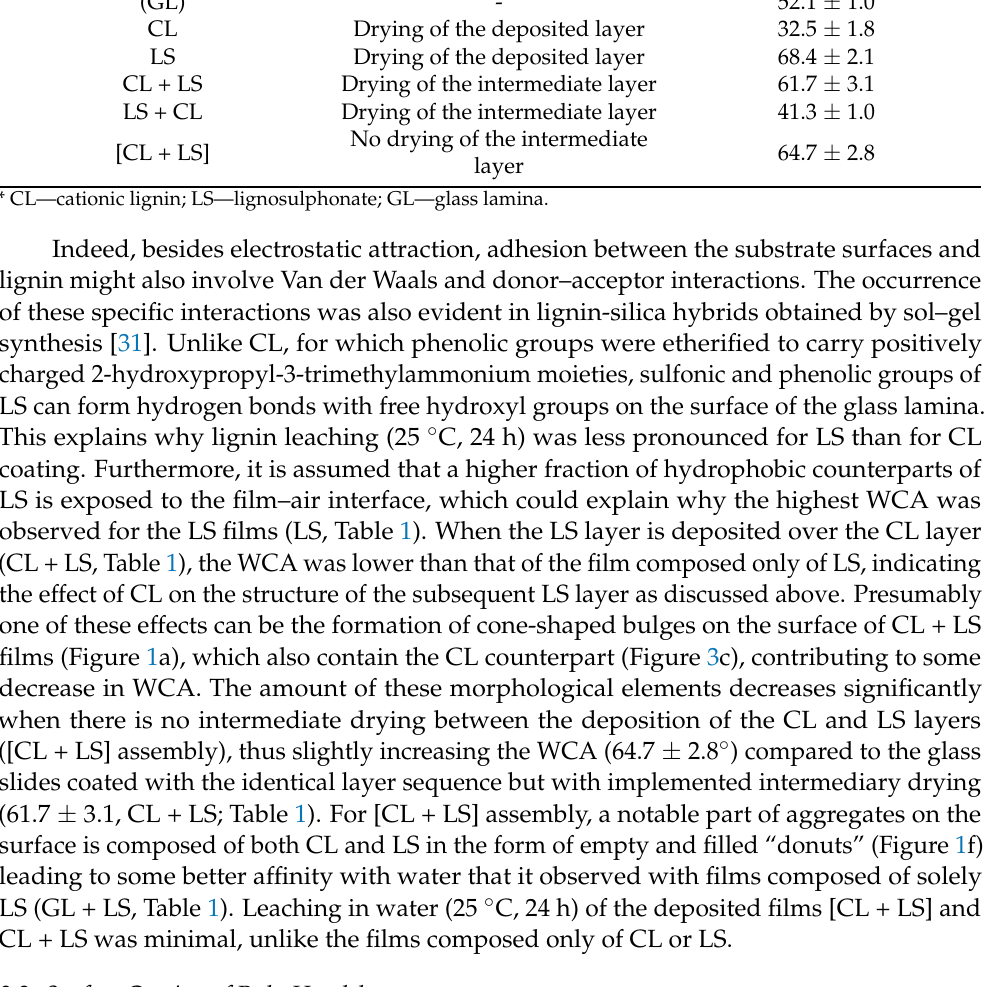
Table 1. Contact angles with water of the films deposited on the glass lamina. * Coating